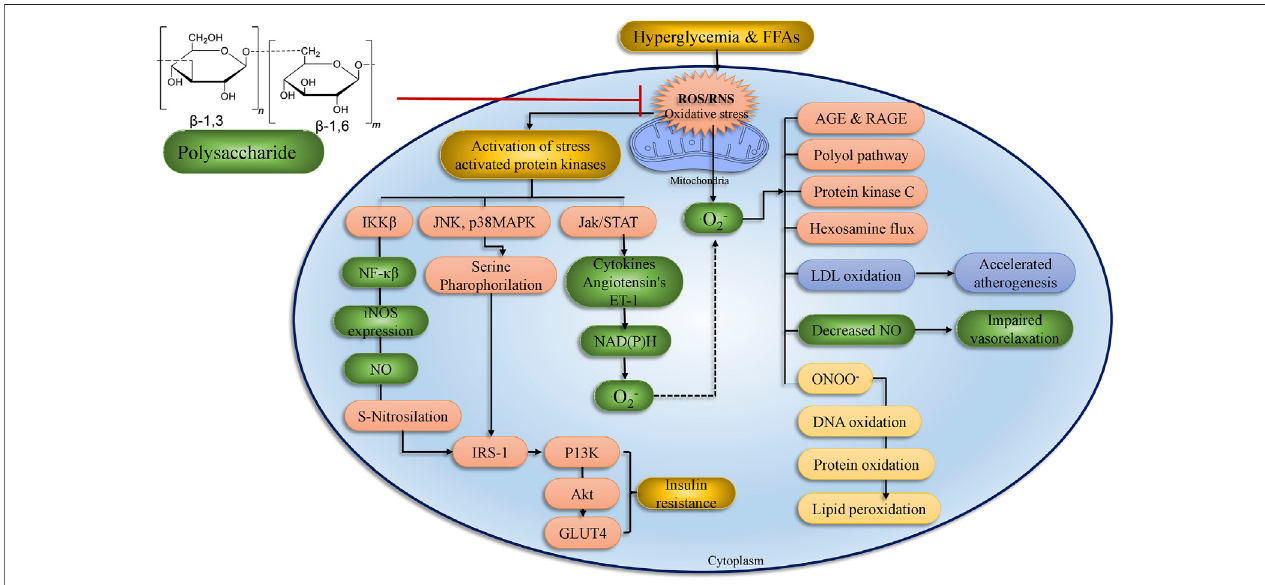
FIGURE 7 | Treatment with polysaccharides has a positive impact on diabetes problems in organs and tissues. ROS formation by hyperglycemia, free fatty acids, and cytokines has a cumulative impact and process. Stress-sensitive pathways such as polyol, advanced glycation end products, PKC, and hexosamine fl ux are activated when mitochondrial ROS levels are too high. The current original study text goes into great detail on the processes. IRS, insulin receptor substrate; ROS, reactive oxygen species; IR: insulin receptor; NF- κ B, Nuclear factor-kappa B; JNK, c-Jun N-terminal kinases; PI3K, phosphoinositide 3-kinase; LPO, lipid peroxidation; AKT, serine/threonine-speci fi c protein kinase; RNS, reactive nitrogen species (adopted from Banerjee and Vats,